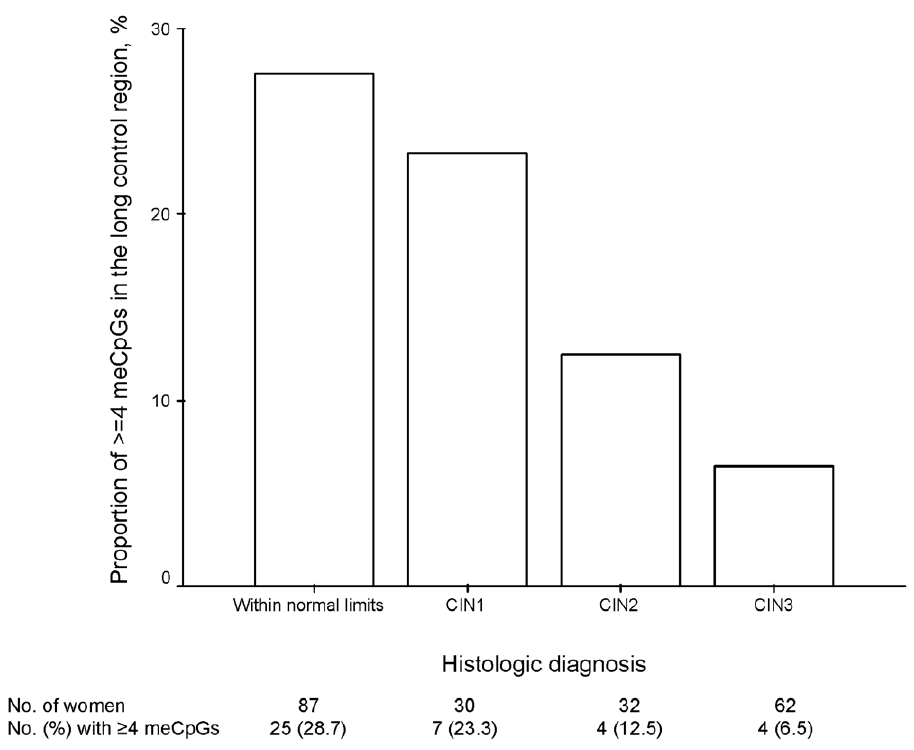
Figure 3. Proportions of $ 4meCpGs in the 3 9 end of the long control region, stratified by cervical lesion severity. doi:10.1371/journal.pone.0023897.g003 PLoS ONE |